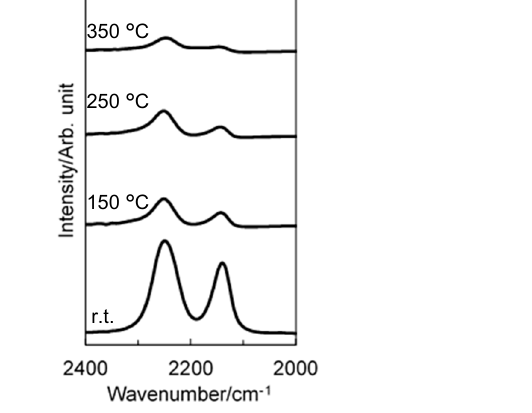
Figure 6. ATR-IR spectra for as-synthesized VH-SQ (room temperature) and those after heat treatment at 150 to 350 ◦ C in N 2 .